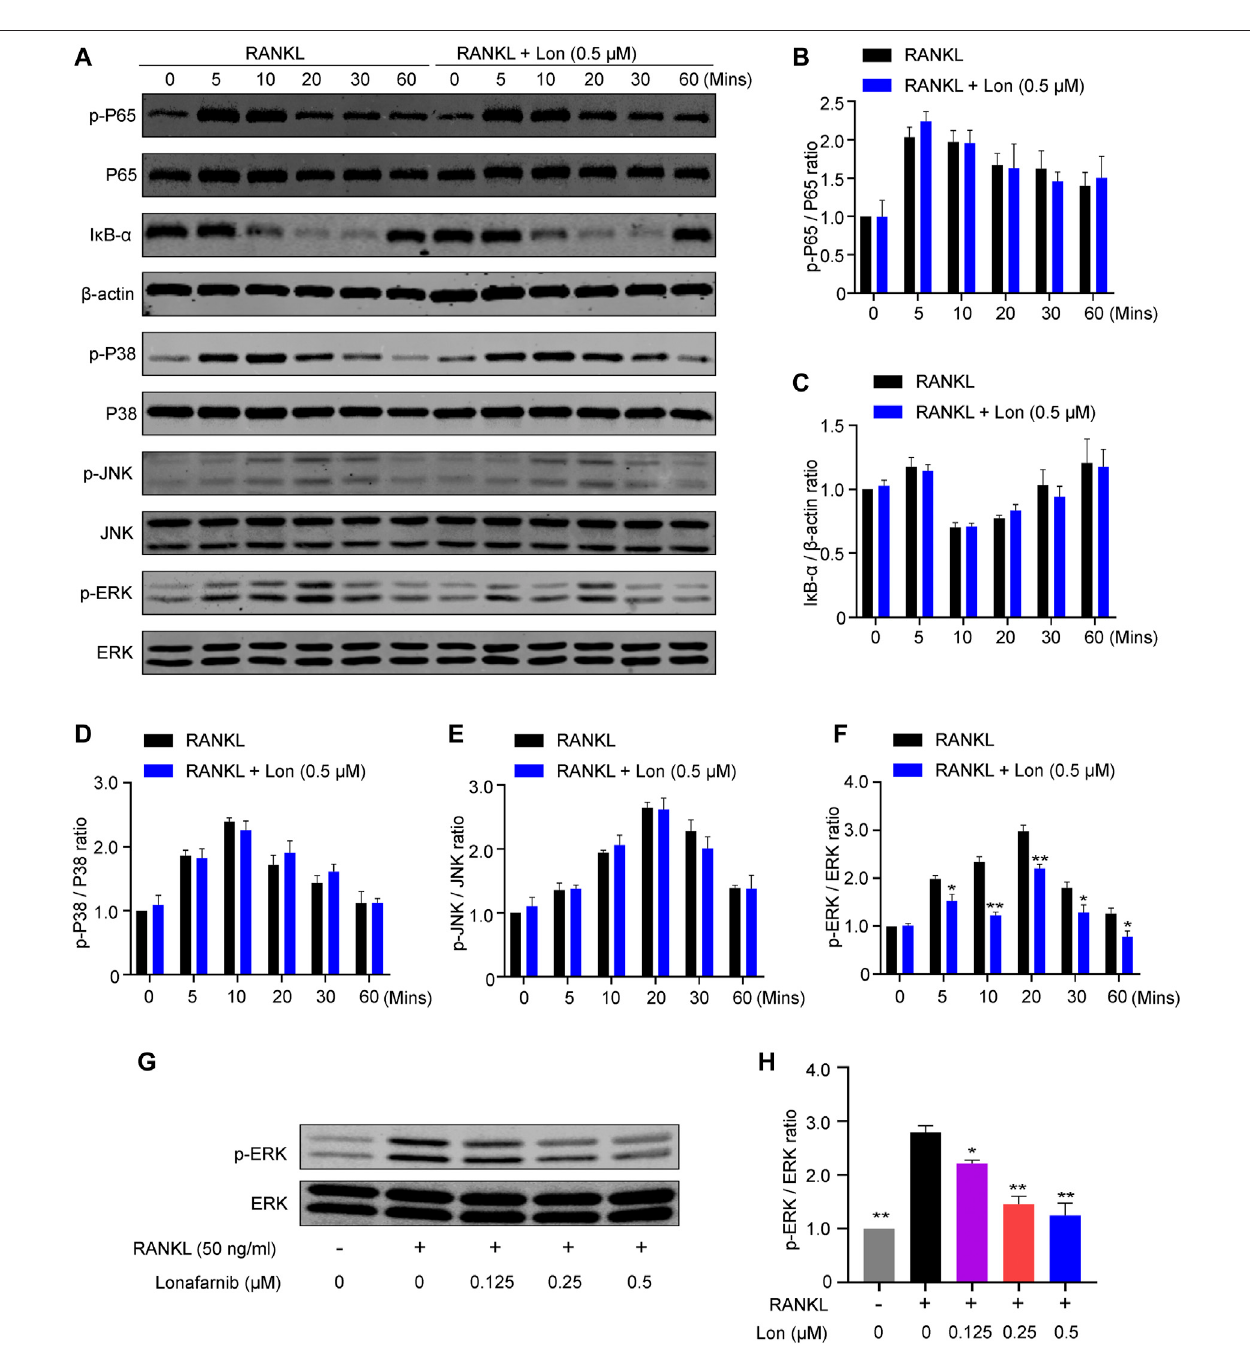
FIGURE8 | Loninhibits the activation ofERK pathway during RANKL-induced osteoclastogenesis. (A) RepresentativeWesternblot images ofthe effect ofLon on RANKL-induced P65 protein phosphorylation, I κ B- α degradation, P38 protein phosphorylation, JNK protein phosphorylation, and ERK protein phosphorylation. (B – F) Quanti fi cation analysisofthe ratioofp-P65 toP65, I κ B- α to β -actin, p-P38 toP38, p-JNK to JNK,and p-ERK toERK ( n =3 per group). (G) Representative Westernblot images of the effect of different concentration of Lon on RANKL-induced ERK protein phosphorylation. (H) Quanti fi cation of the ratio of p-ERK to ERK treated with different concentration of Lon. All of the above data are expressed as the mean ± SD, n = 3 per group. * p < 0.05, ** p < 0.01 relative to RANKL-induced control group. BMMs, bone marrow macrophages; Lon, Lonafarnib; RANKL, receptor activator of nuclear factor- κ B ligand.